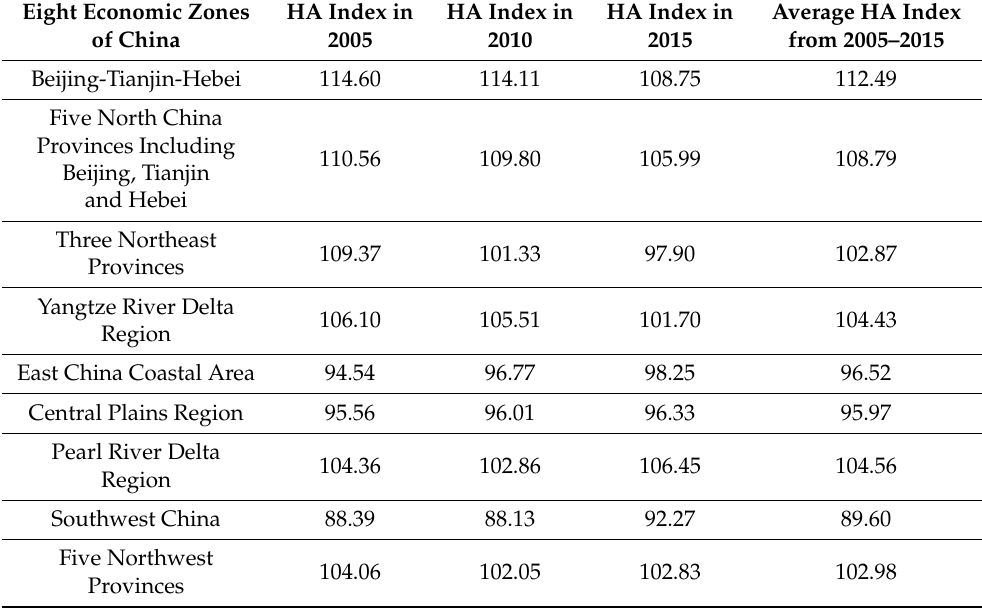
Table 8. Regional HA index of eight economic zones of